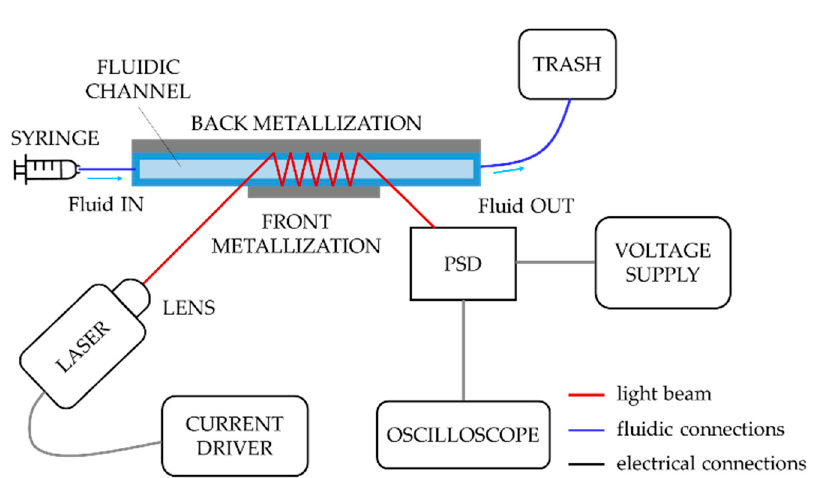
Figure 1. Schematic representation of the instrumental configuration for optical detection. The output signals supplied by the PSD are visualized in real time and acquired with an oscilloscope. Data are further processed in a MATLAB